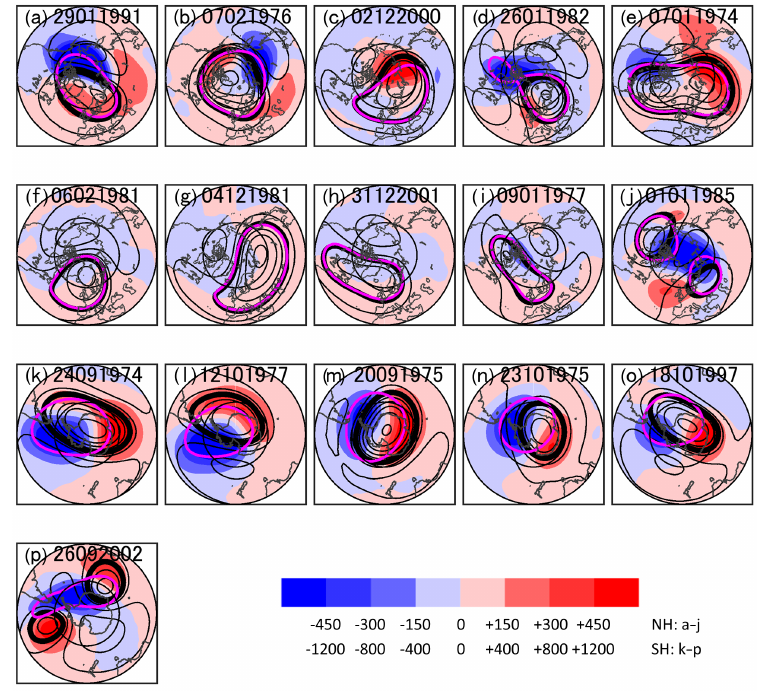
Figure 9. (Black contours in (a–e) and (k–o) .) Maps of the 10hPa height in STDD for the five largest RMSD values: (a–e) NH and (k–o) SH. These labels are the same as in Fig. 8a, b. The target dates are also denoted in the ddmmyyyy format. The contour interval is 500m, and thick black contours denote 30000m in STDD. Magenta contours denote 30000m for the 10hPa height in CONV on the same dates. Color shades denote differences of CONV from STDD (see the color bar). Panels (f–j) are similar, but for the three missed MSSW cases and the two delayed cases in NH. These labels are also denoted in Fig. 8a, c. Panel (p) is similar, but for the 2002 MSSW in SH (see Fig.